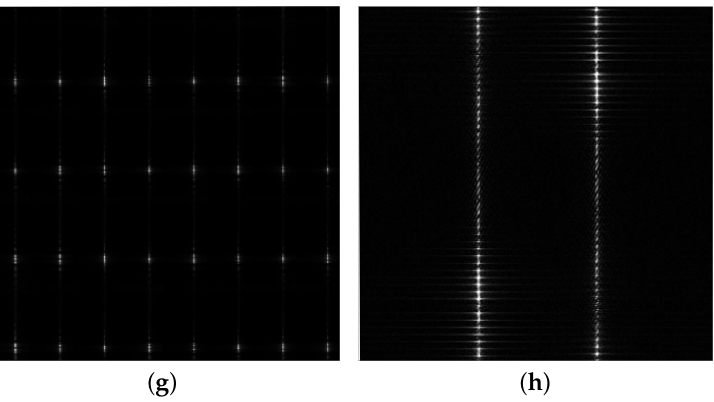
Figure 4. DR2D features of typical radiation source signals. ( a ) DRP of a continuous wave signal; ( b ) ORP of a continuous wave signal; ( c ) DRP of a triangle wave frequency modulation signal; ( d ) ORP of a triangle wave frequency modulation signal; ( e ) DRP of a pulse amplitude modulation signal; ( f ) ORP of a pulse amplitude modulation signal; ( g ) DRP of a binary phase shift keying signal; ( h ) ORP of a binary phase shift keying signal.